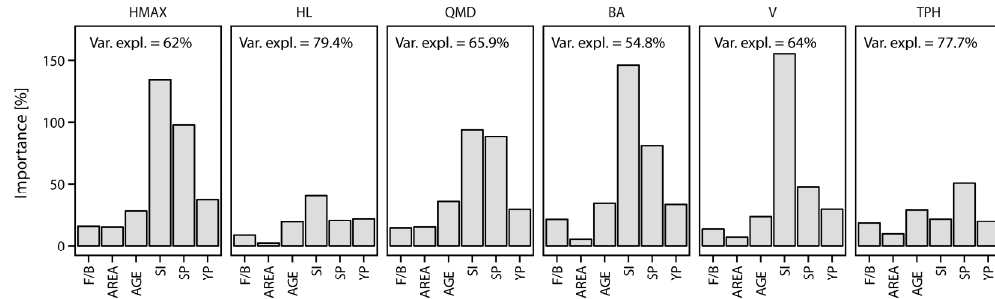
Figure 9. Importance of stand age (AGE), site index (SI), dominant species (SP), forward or backward projection method (F/B), stand area (AREA), and number of years projected (YP) calculated with random forest for relative differences between cell ‐ and stand ‐ level prediction of inventory attributes.